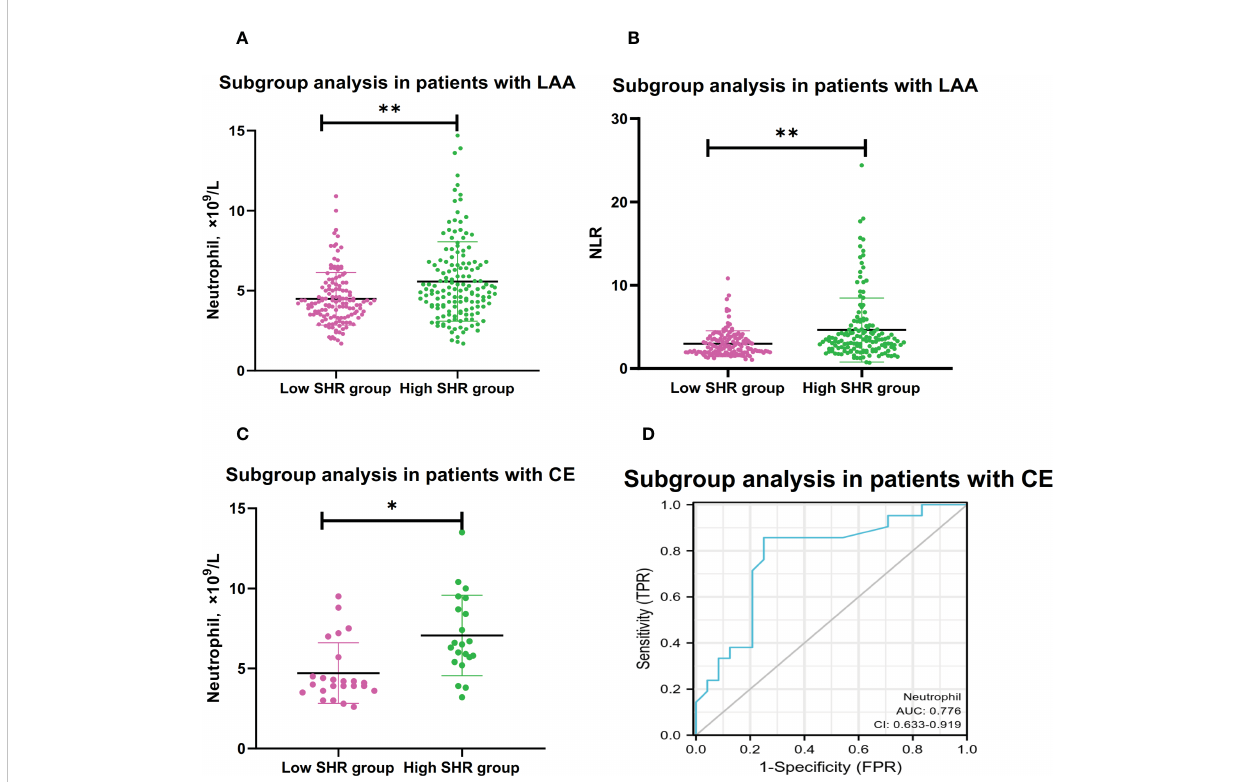
FIGURE 2 Subgroup analyses for association between neutrophil and NLR with high SHR group. (A) Comparison of neutrophil counts between low SHR group and high SHR group in patients with LAA. (B) Comparison of NLR between low SHR group and high SHR group in patients with LAA. (C) Comparison of neutrophil counts between low SHR group and high SHR group in patients with CE. (D) ROC analysis of predication performance of neutrophil for high SHR group in patients with CE. (Neutrophil: AUC 0.776, 95% CI 0.633-0.919; P=0.002, speci fi city 0.750, sensitivity 0.857; optimal cut-off: 4.850) (*P <0.05, **P <0.001). NLR, neutrophil-to-lymphocyter ratio: SHR-fasting blood glucose AUC: Areas under the receiver operating characteristics curve (ROC) curves.